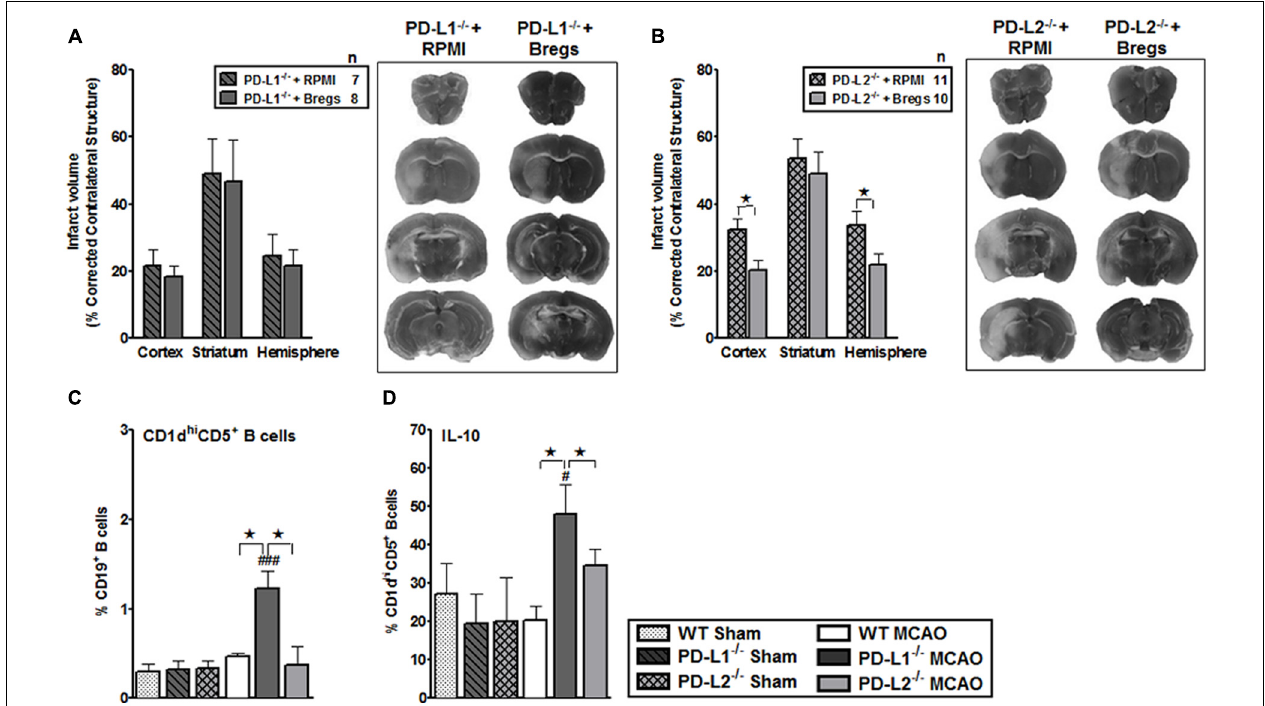
FIGURE 8 | Bregs decrease infarct volumes in male PD-L2 − / − mice, but are dispensable when transferred to PD-L1 − / − mice 4 h after MCAO. (A) Intravenous transfer of 5 million IL10 + B-cells 4 h aftersurgery to induce MCAO in PD-L1 − / − mice 96 h following 60 min of MCAO compared to intravenous transfer of RPMI vehicle (no cells) and its representative 2,3,5-triphenyltetrazolium chloride (TTC) stained cerebral sections 96 h following 60 min of MCAO. (B) Intravenous transfer of 5 million IL10 + B-cells 4 h after surgery to induce MCAO in PD-L2 − / − mice 96 h following 60 min of MCAO compared to intravenous transfer of RPMI vehicle (no cells) and its representativeTTC stained cerebral sections 96 h following 60 min of MCAO.